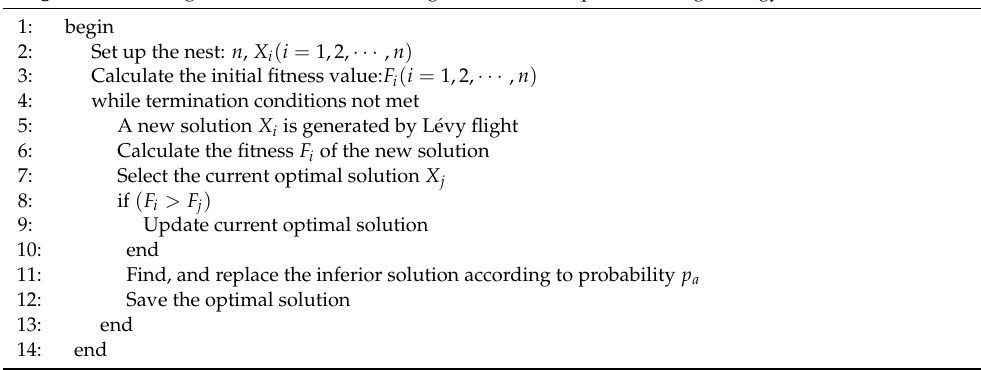
Algorithm 1: CS algorithm to solve the walking distance of composite routing strategy.